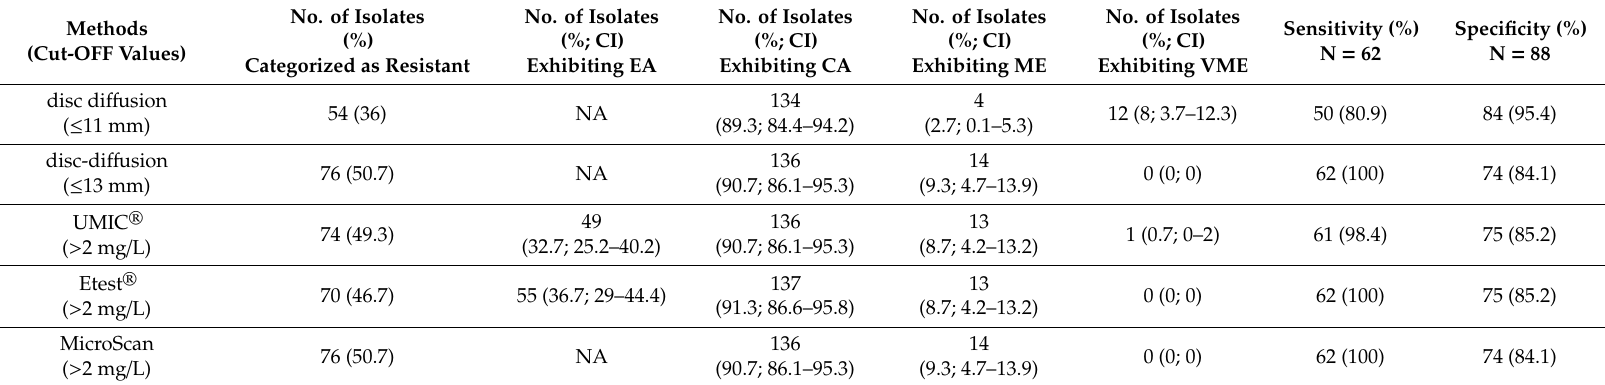
Table 1. Results of essential agreement (EA), categorical agreement (CA), major error (ME), very major errors (VMEs), sensitivity and specificity for all tests in comparison with the standard